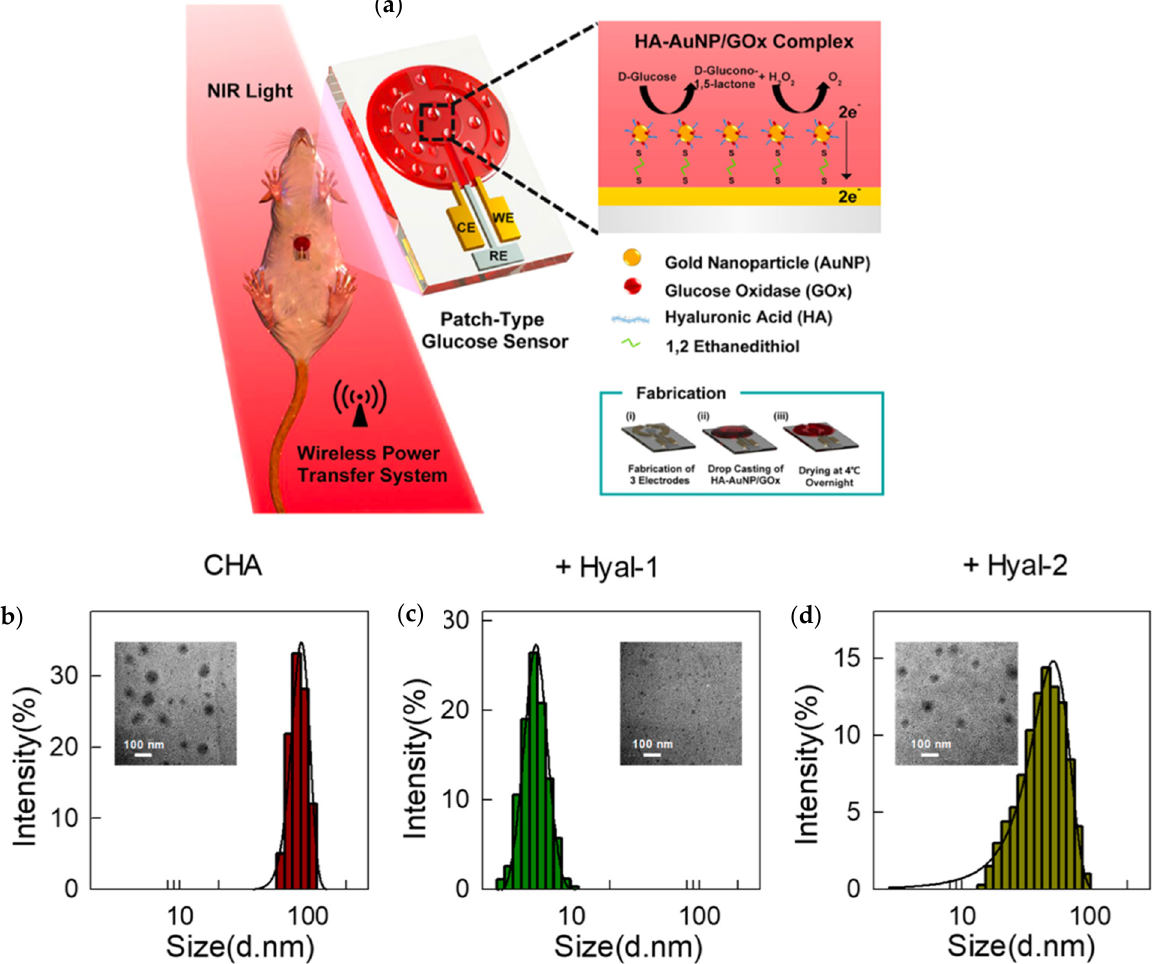
Figure 6. ( a ) Fabrication and application of a wireless glucose sensor used to test sweat for glucose concentration and consisting of an HA-AuNP/GOx complex casted on an electrode surface. Reprinted with permission from ref. [22]. 2019 American Chemical Society. ( b – d ) TEM imaging and size distribution corresponding to a 10 µ g/mL solution of CHA without the addition of any hyaluronidase, CHA with 20 µ g/mL Hyal-1, and CHA with 20 µ g/mLHyal-2, respectively. Reprinted with permission from ref. [24]. 2019 American Chemical Society.